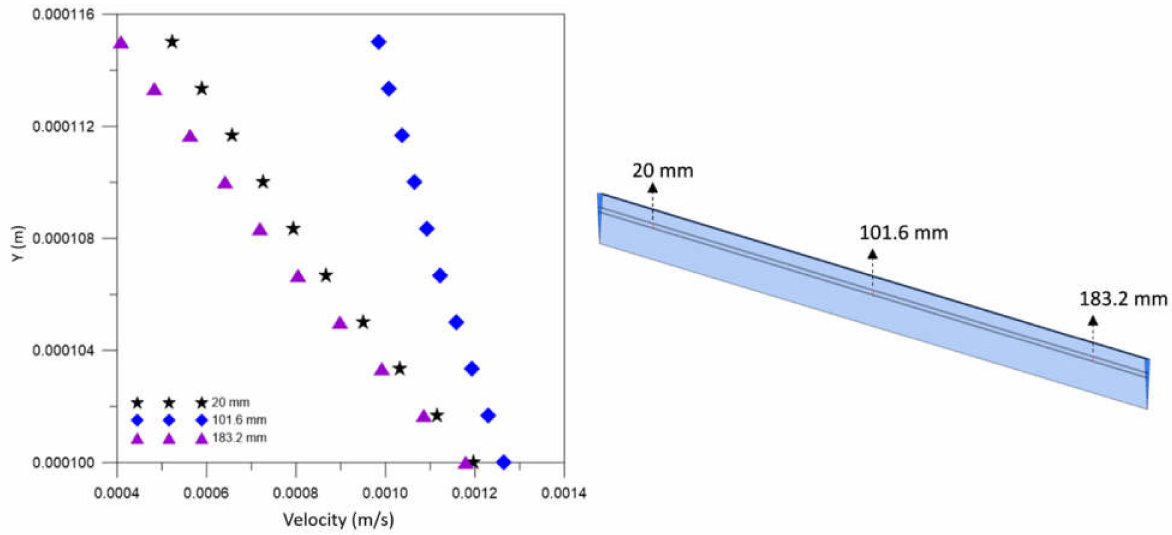
Figure 15. Velocity profile of urea inside the membrane, in the axial positions 20.0 mm, 101.6 mm, and 183.2 mm, at t = 6200 s (Case 9).